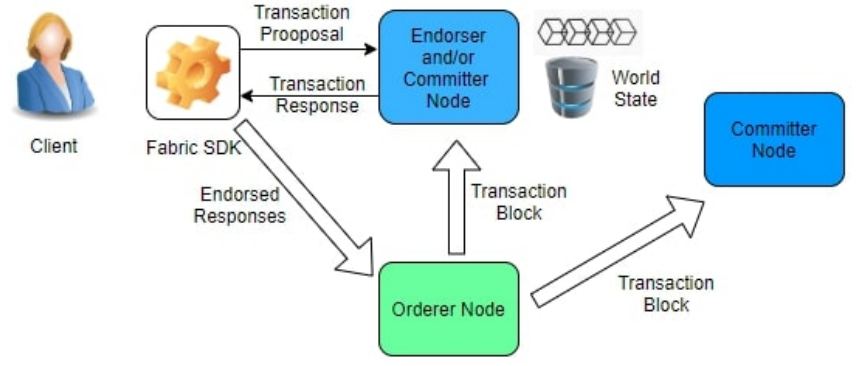
Figure 7. Block header and transaction sequence using